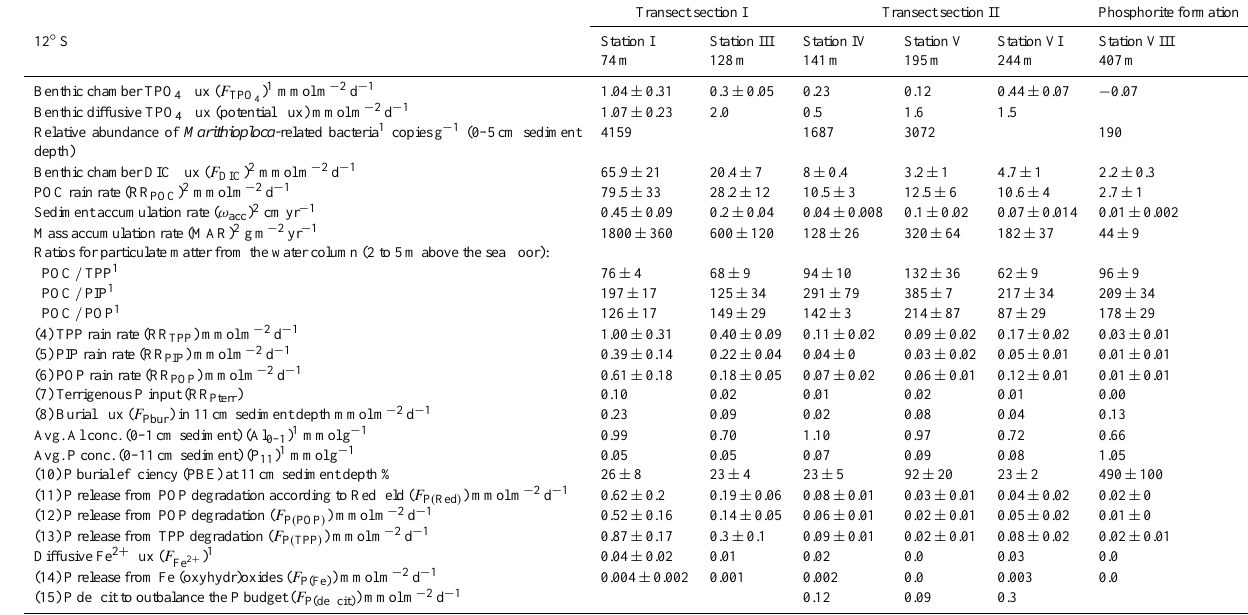
Table 4. Measured and calculated parameters for the P mass balance along the 12 ◦ S transect. The numbers in front of key parameters correspond to equations in Table